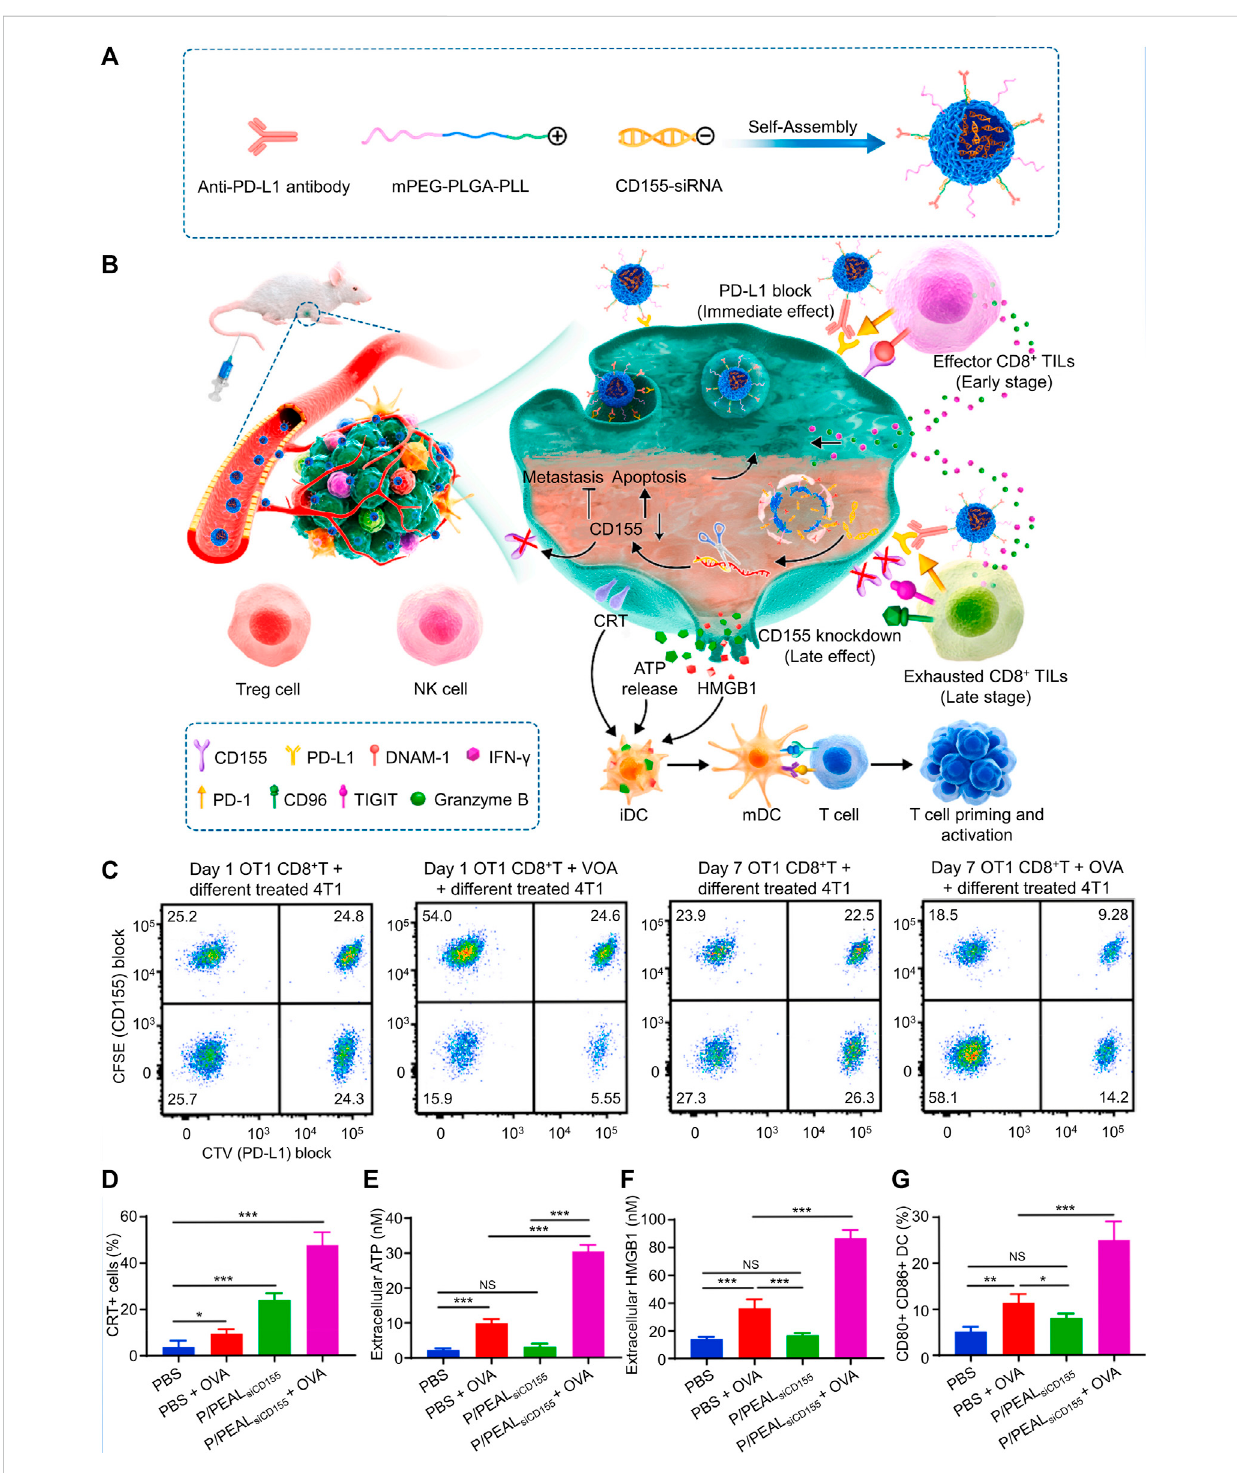
FIGURE 4 Immune checkpointtherapy was made easier by P/PEAL siCD155 , whichasynchronously inhibited PD-L1 and caused immunogenic cell death (ICD) in a spatiotemporal way. (A) Schematic illustration of P/PEAL siCD155 . (B) Schematic representation of the treatment of P/PEAL siCD155 -mediated combined immunotherapy in tumor model. (C) Examining the CD155 and PD-L1 intensity to determine the percentage of 4T1 cells that were subjected to various treatments. (D – G) ICD in 4T1 cells including CRT (D) , ATP (E) , and HMGB1 (F) is triggered by P/PEAL siCD155 . (G) DC maturation in vitro . Data are represented as mean ± SD ( n = 3; * p < 0.05, ** p < 0.01, *** p < 0.001). Reproduced with permission (Chen et al., 2021) Copyright © 2023,